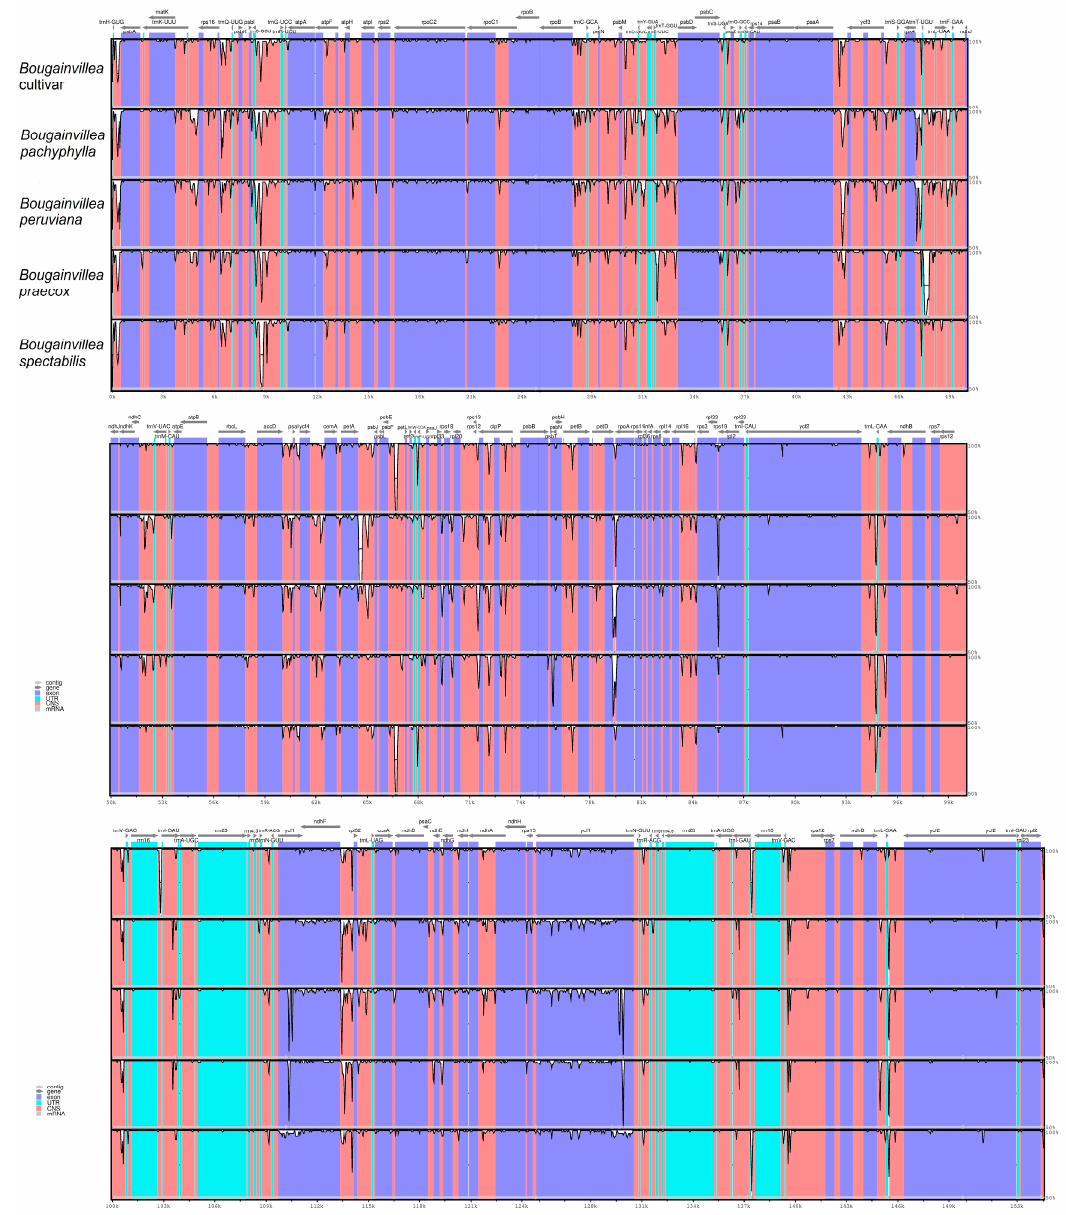
Figure 6. Sequence identity plots (mVISTA) among Bougainvillea species. Alignments of the five Bougainvillea plastomes, with Bougainvillea glabra as the reference genome. Genes are color-coded, whereby pink regions represent conserved non-coding sequences (CNS) and purple regions indicate protein-coding sequences. Grey arrows above the alignments indicate gene directions. The y-axis denotes the percentages of identity, ranging between 50% and 100%.